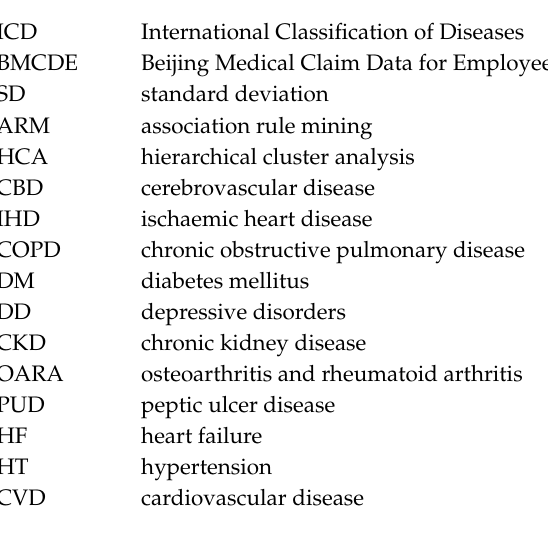
Table S1: The ICD-10 codes for the select diseases